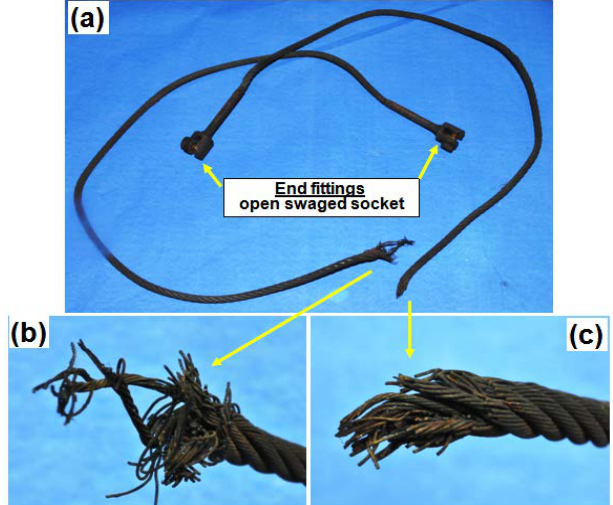
Figure 1: Photograph of failed wire rope: (a) as-received condition, (b) one end of the broken rope, (c) another end of the broken rope displays several wires unwound from its strands and loosens from their